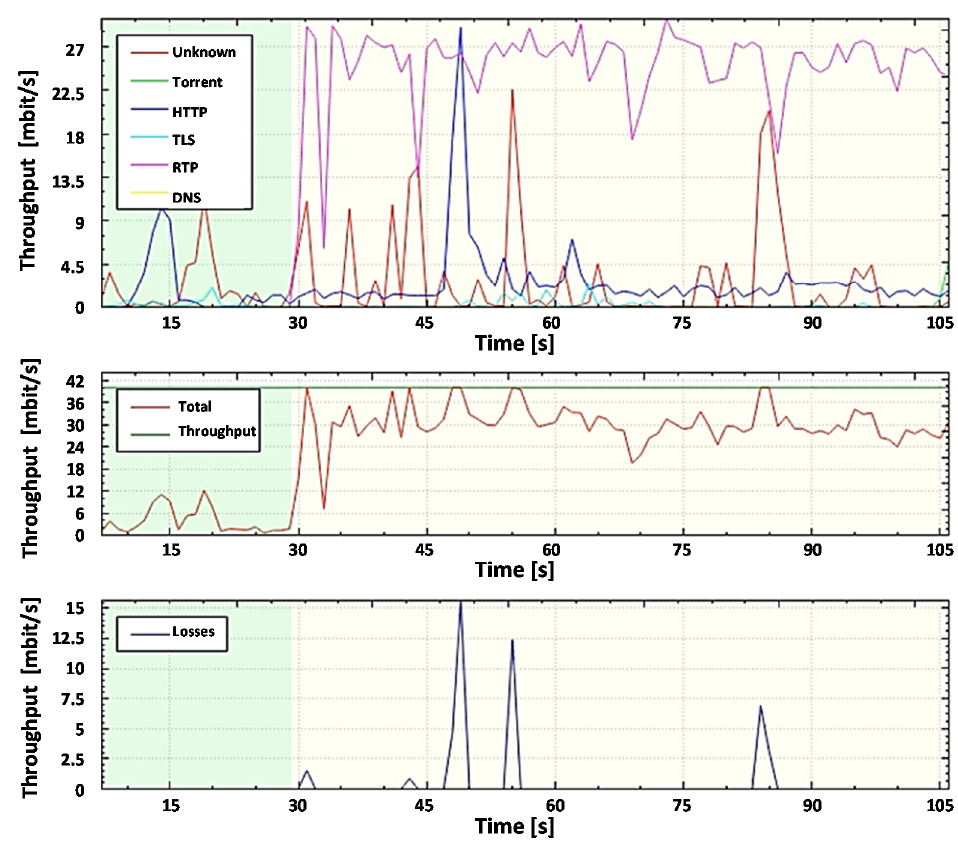
Figure22. Throughputmonitoring, inthetransmissionoflegitimatetra ffi cusingtheexistingSolarWinds DPI and the proposed DPI